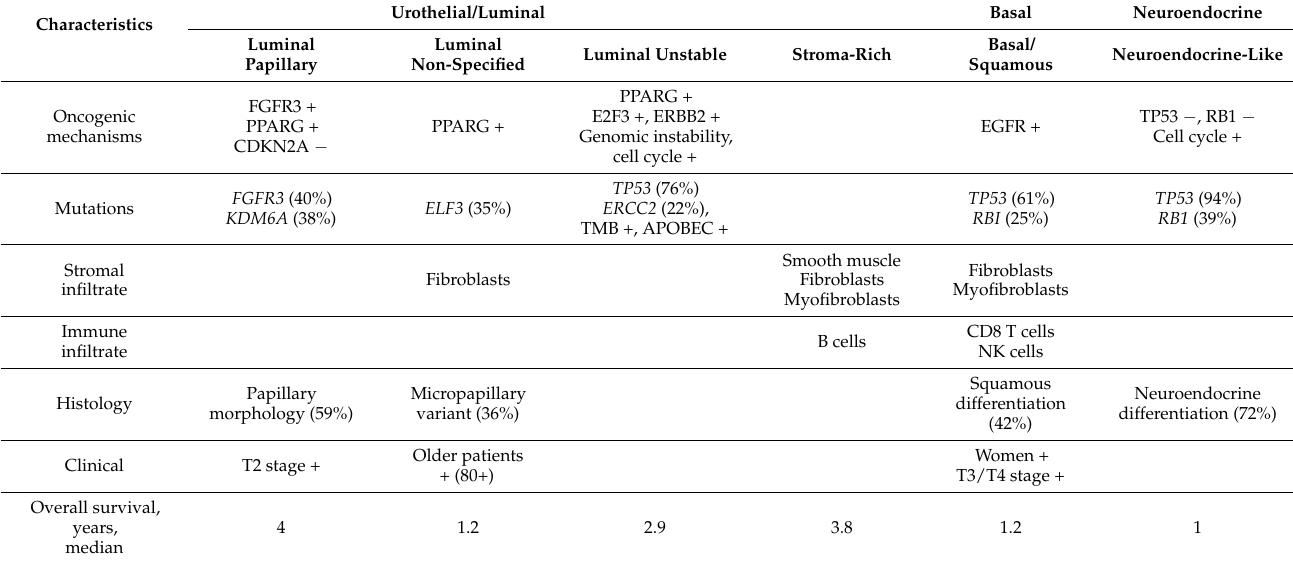
Table 4. ACGT consensus molecular subtypes of MIBC tumors